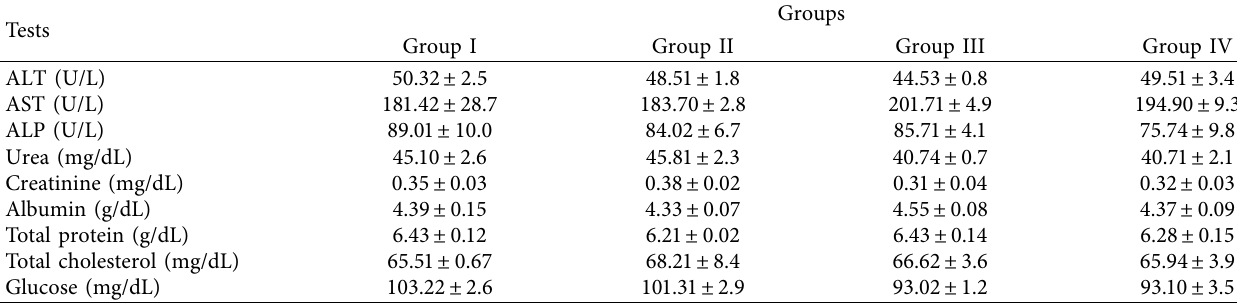
Table 5: Biochemical profle of female rats treated with leaf extract of R. prinoides .